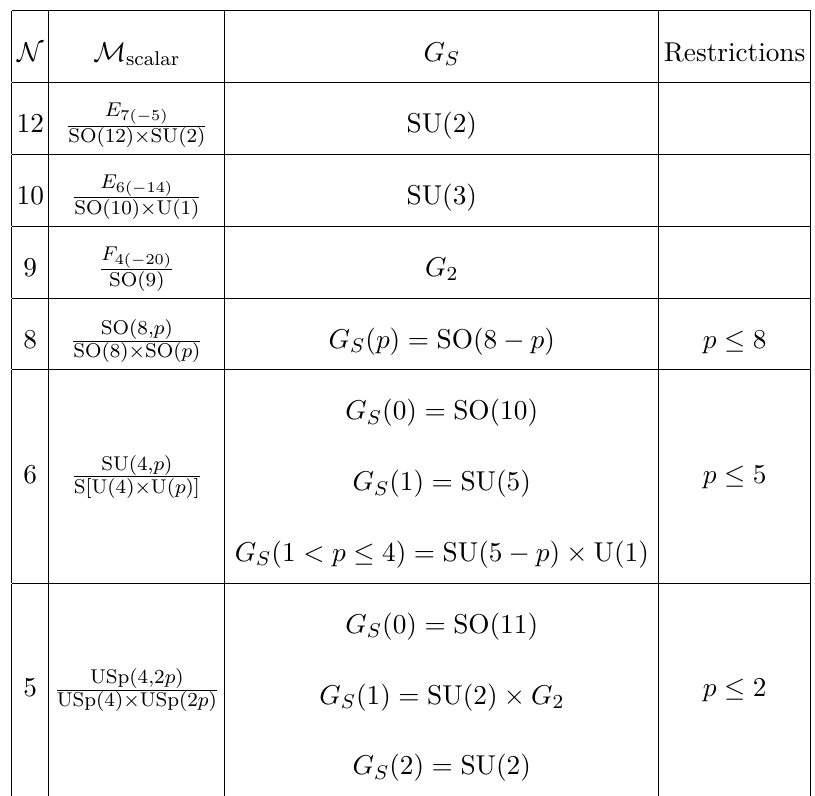
Table 1 . Summary of the possible truncations to N > 4 gauged supergravities. G S denotes the structure group, with the notation G S ( p ) for p matter multiplets, M scalar the scalar manifold and the restrictions on the number of matter multiplets that can be kept in a truncation, where